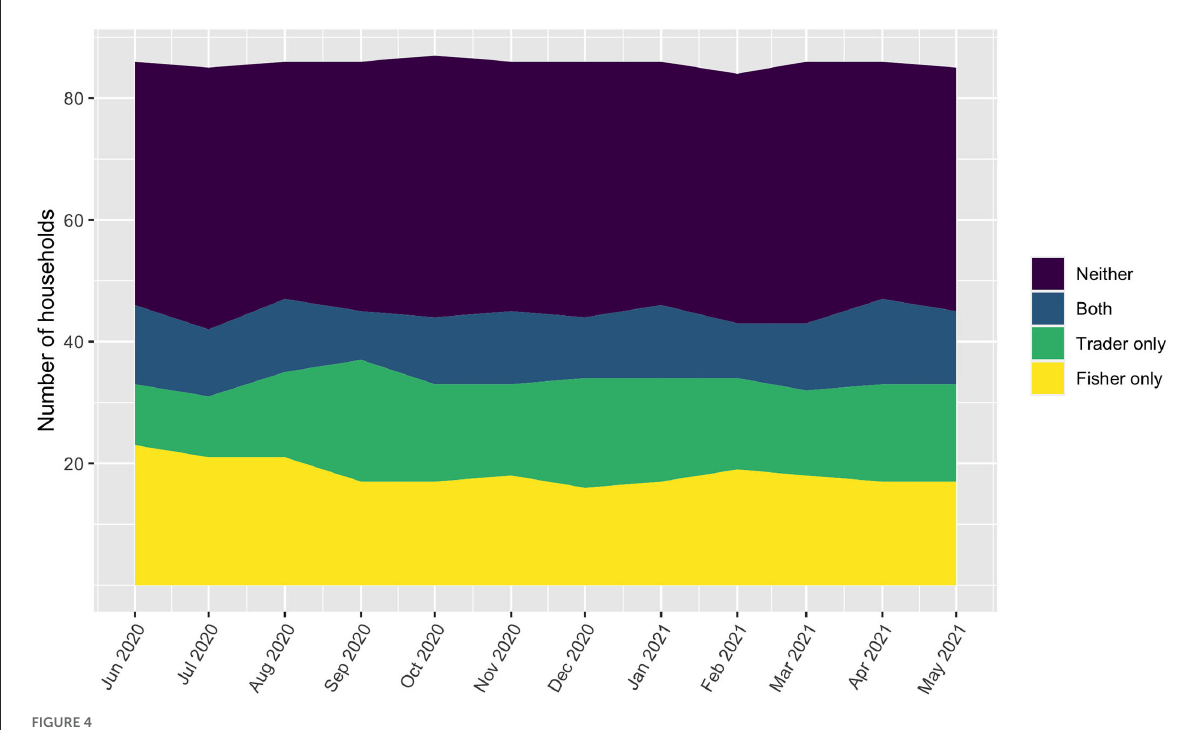
FIGURE4 Household participation in fishing, trading, both or neither in past 7 days.